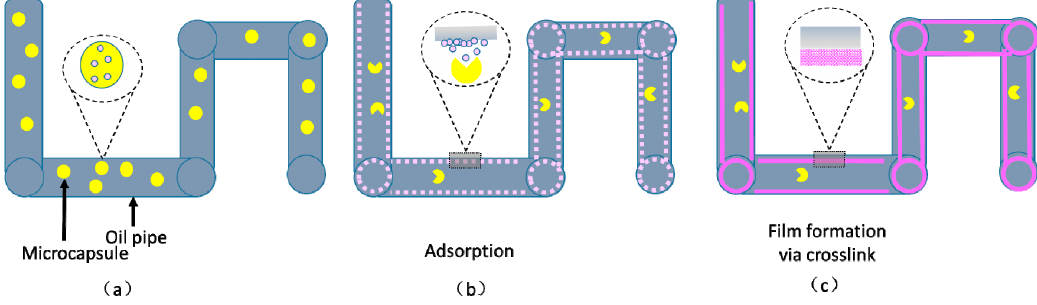
Figure 7. Mechanism of corrosion inhibitor in an oil pipe. ( a ) Transportation of microcapsules; ( b ) release of corrosion inhibitor and ( c ) inert film formation.